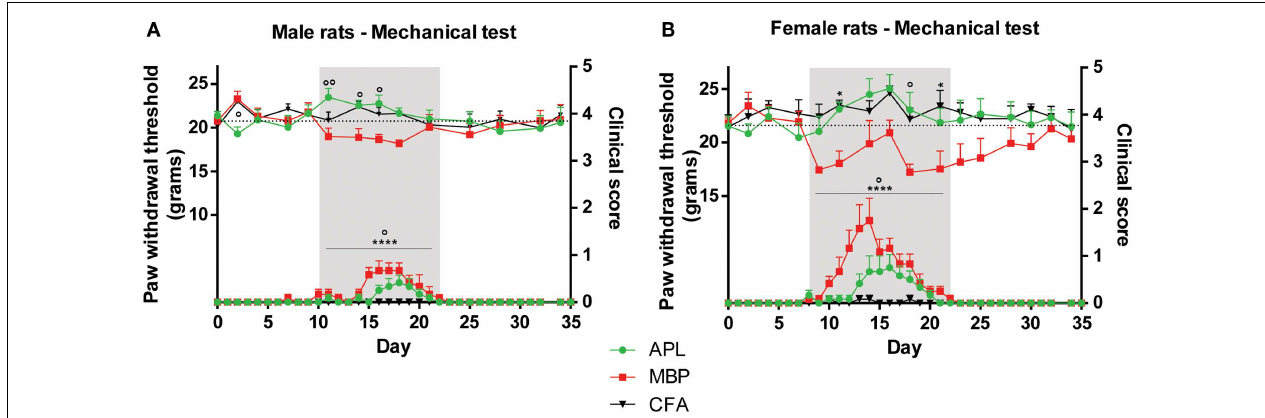
MBP animals generally exhibited lower pain thresholds, while APL animals maintained thresholds similar to control. ( n = 6 per group; * p < 0.05, **** p < 0.0001, MBP compared to control; ◦ p < 0.05, ◦◦ p < 0.01, APL compared to MBP; two-way ANOVA with Bonferroni’s post-tests for upper panel, Mann–Whitney test for lower panel). Gray region indicates periods of established disease. Dotted line represents mean baseline values. Data expressed as mean ±